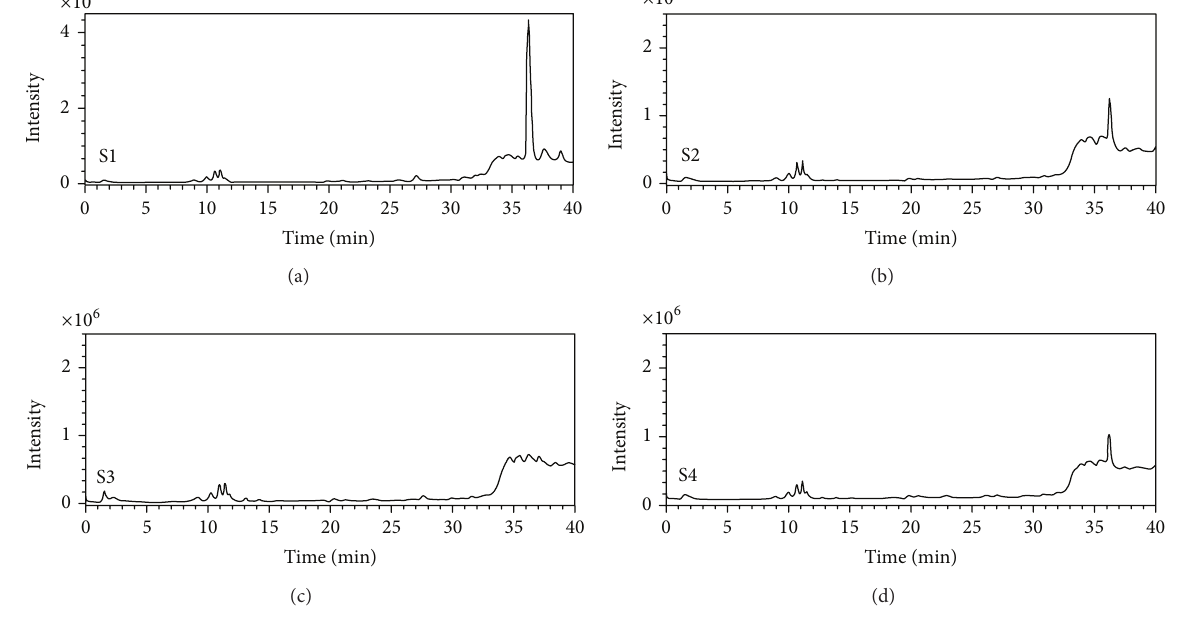
Figure 9: HPLC analyses of organic matters in Zuota samples.